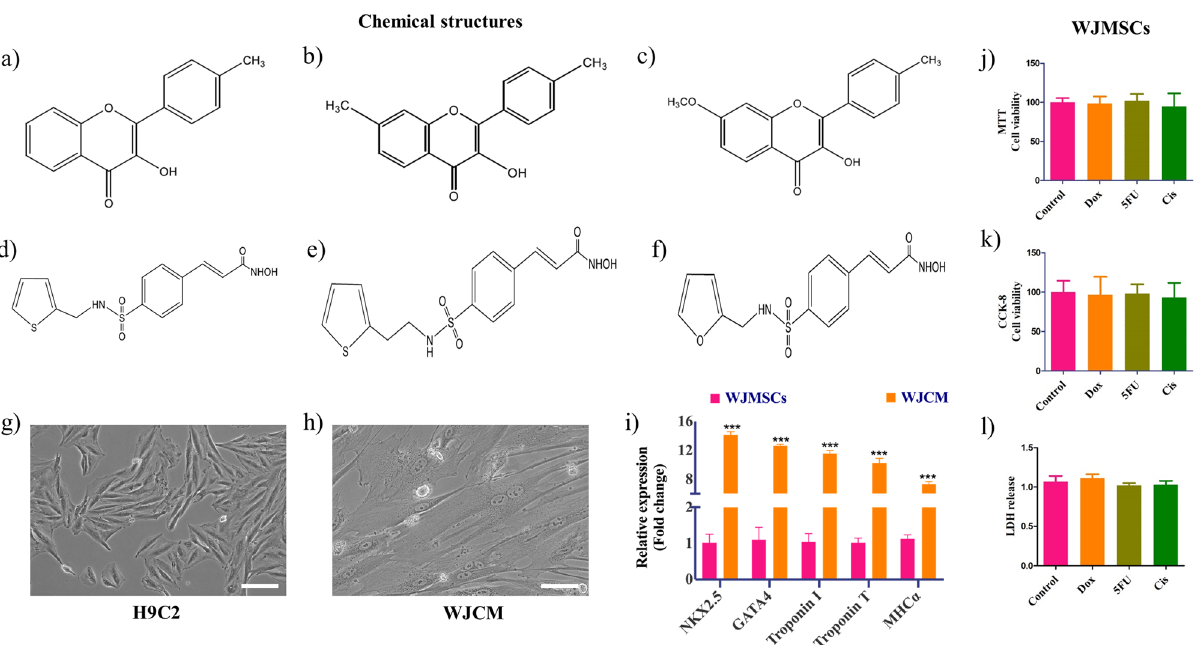
Figure 1. Culture of H9C2 cells and cardiomyocytes derived from WJMSCs (WJCM) and its characterization. The chemical structure of the analogues of quercetin ( a ) QMJ-2 (Chemical Name: 3-hydroxy-2-(4-methylphenyl)-4H-1-benzopyran-4-one), ( b ) QMJ-5 (Chemical Name: 3-Hydroxy- 7-methyl-2-(4-methylphenyl)-4H-1-benzopyran-4-one), ( c ) QMJ-6 (Chemical Name: 3-Hydroxy-7- methoxy-2-(4-methylphenyl)-4H-1-benzopyran-4-one), and cinnamic acid ( d ) NMJ-1 (Chemical name: (E)-NHydroxy-3-(4-(N-(thiophen-2yl)methyl)sulfamoyl)phenyl)acrylamide), ( e ) NMJ-2, (Chemical Name: (E)-NHydroxy-3-(4-(N-(thiophen-2yl)ethyl)sulfamoyl)phenyl)acrylamide) ( f ) NMJ-3 ((E)-NHydroxy-3-(4- (N-(furan-2yl)methyl)sulfamoyl)phenyl)acrylamide). Photomicrographs of ( g ) H9C2 cells and, ( h ) WJMSCs differentiated into cardiomyocytes (WJCM). ( i ) qRT-PCR analysis shows an increase in the gene expression of cardiac markers, NKX2.5, GATA4, Troponin I, Troponin T, and MHC-alpha in WJCM. Scale bar 50 μm. The cytotoxicity assays ( j ) MTT cell viability, ( k ) cell counting kit-8 (CCK-8), and ( l ) LDH release were performed in WJMSCs. Data represented as mean ± SEM (n = 3), ***p < 0.001. Dox doxorubicin, 5FU 5-fluorouracil, Cis